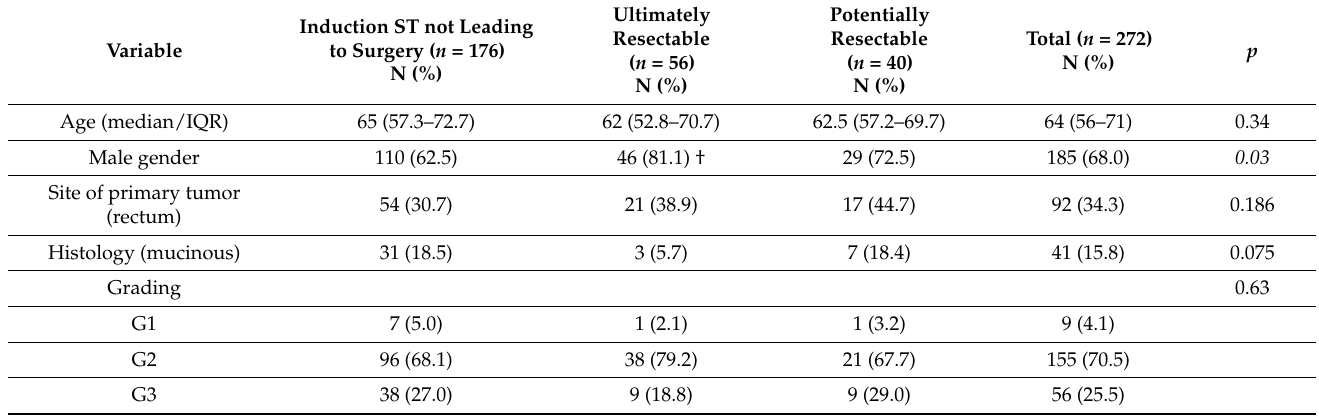
Table 1. Clinicopathological, preoperative, and surgical characteristics of CRLM patients undergoing liver